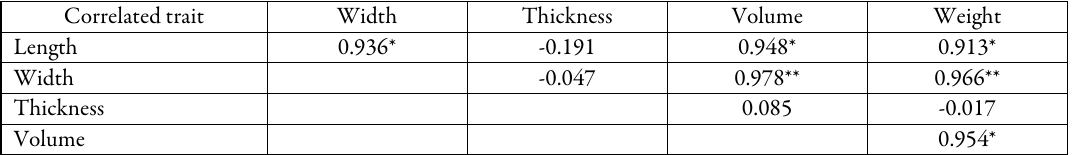
Table 4. Phenotypic correlations between the analysed characteristics of the seeds harvested from the R. pseudoacacia plus trees from the five stands